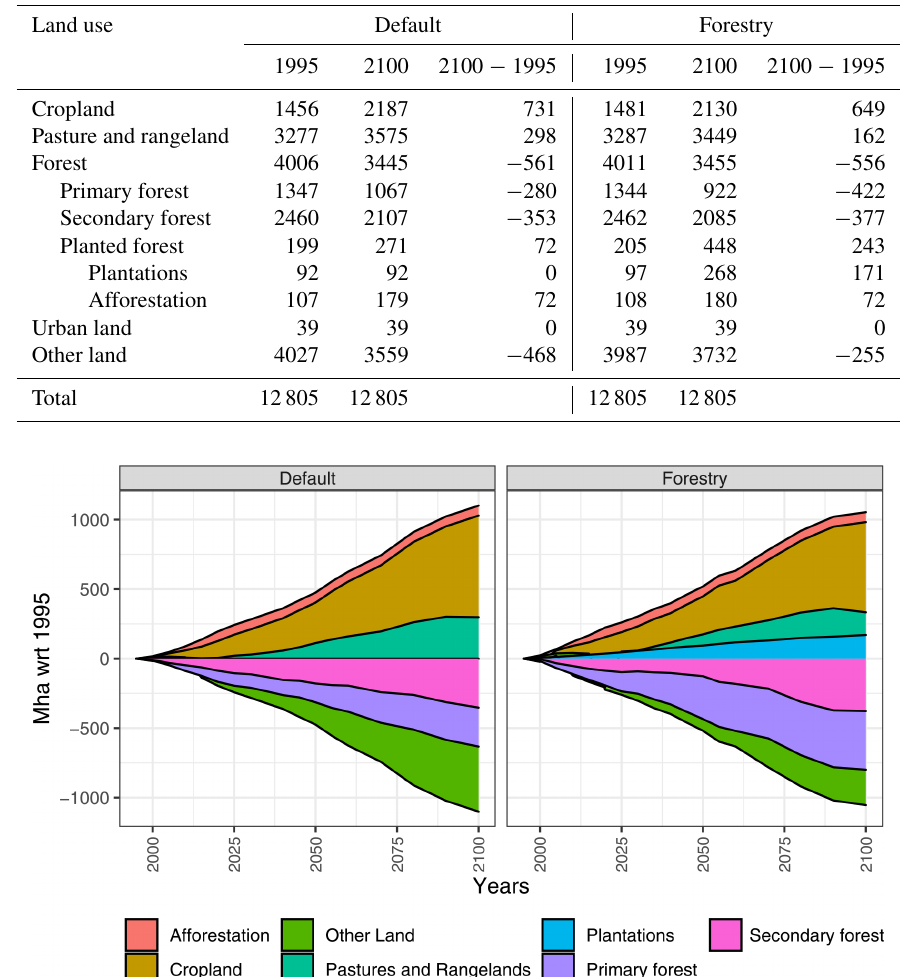
Figure 10. Relative land-use change between 1995 and 2100 at the global level for the default and forestry scenarios. All values are with respect to 1995 (in Mha). Region-specific results are shown in Fig.